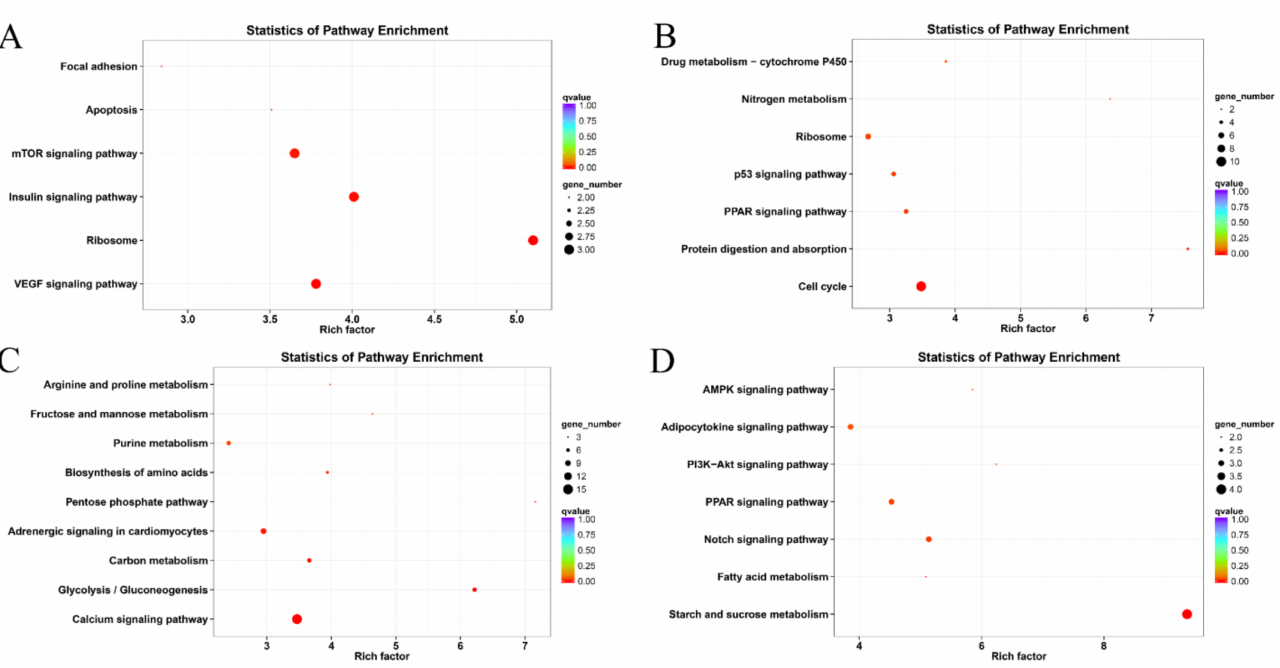
Figure 5. Kyoto Encyclopedia of Genes and Genomes enrichment analysis of genes within highly correlated modules. ( A ) darkorange module; ( B ) magenta module; ( C ) saddlebrown module; ( D ) darkolivegreen